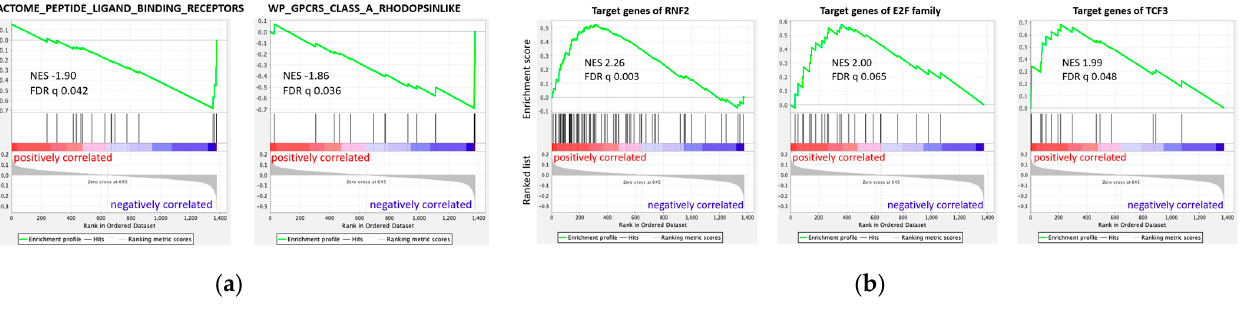
Figure 6: Enrichment plots of gene set enrichment analysis (GSEA) analysis on 1376 genes ordered by positive to negative correlation with SUVmax. ( a ) For canonical pathways (C2cp), 2 gene sets of rhodopsin-like receptors are enriched among genes that are negatively associated with SUVmax: “REACTOME_PEPTIDE_LIGAND_BINDING_RECEPTORS” and “WP_GPCRS_CLASS_A_RHODOPSINLIKE”. ( b ) Three transcription factors (in C3tft) show enrich- ment of their target genes among genes that are positively associated with SUVmax: RNF2, E2F family,